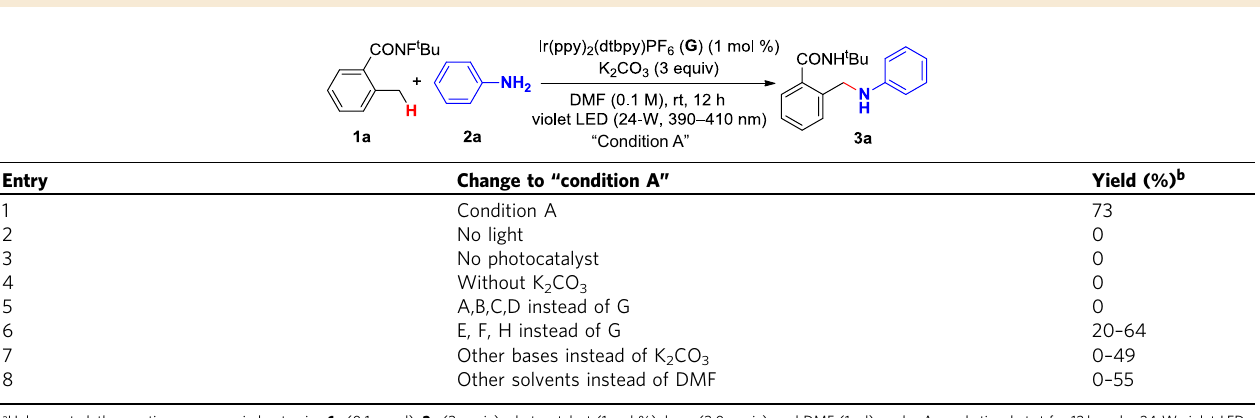
Table 1 Optimization of reaction conditions a